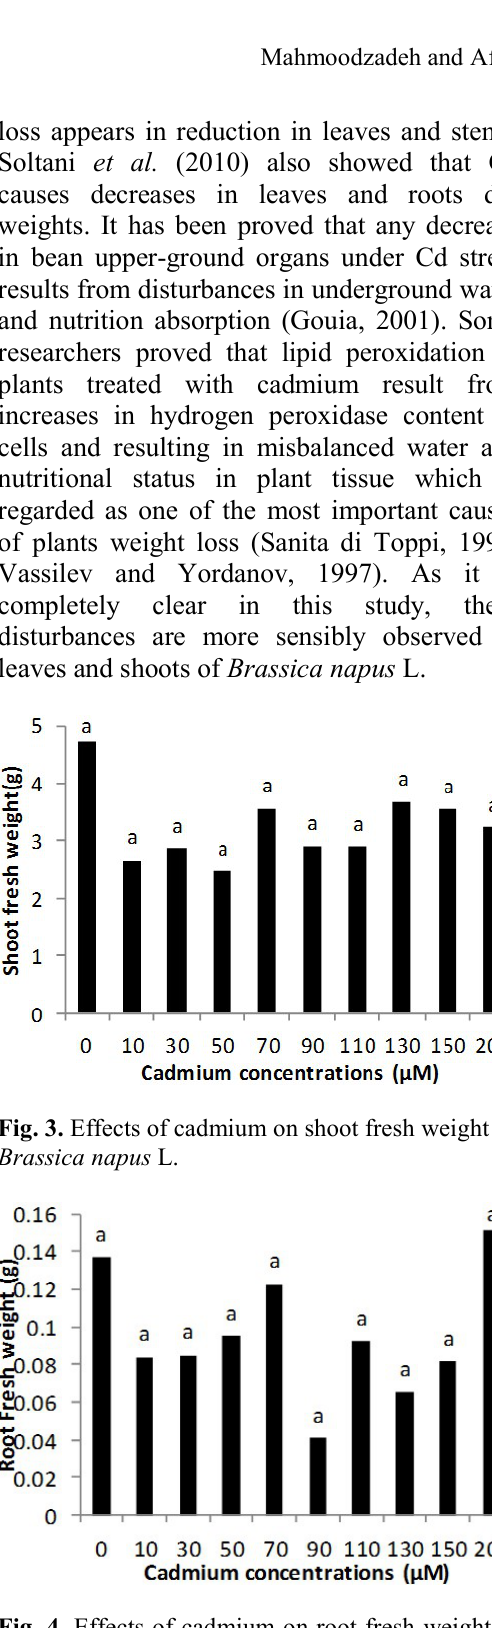
Fig. 7 . Effects of cadmium on SPAD of Brassica napus